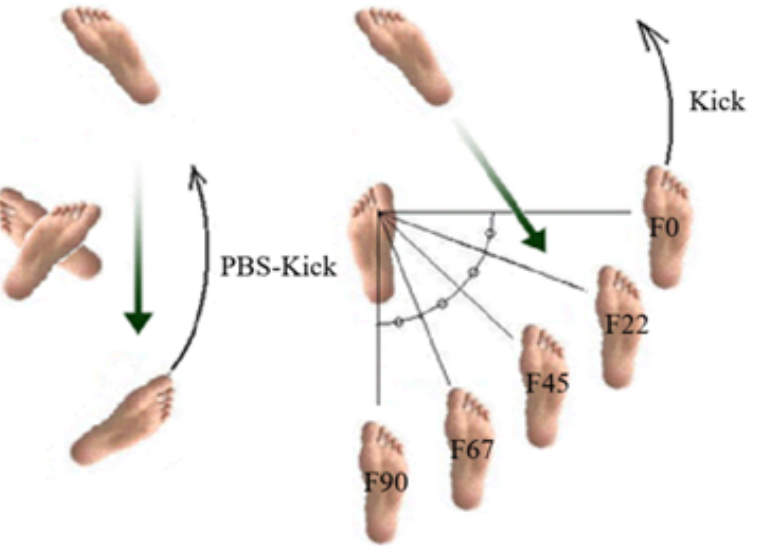
Figure 3. Angle-change types of footwork.